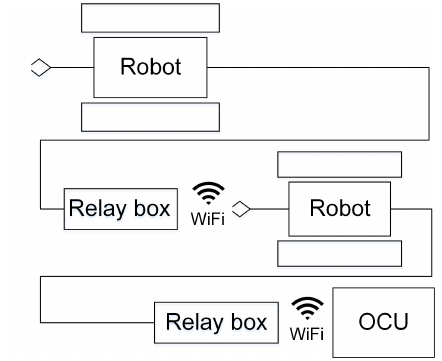
Figure 2. The illustration of robots communicating in series. OCU, operating control